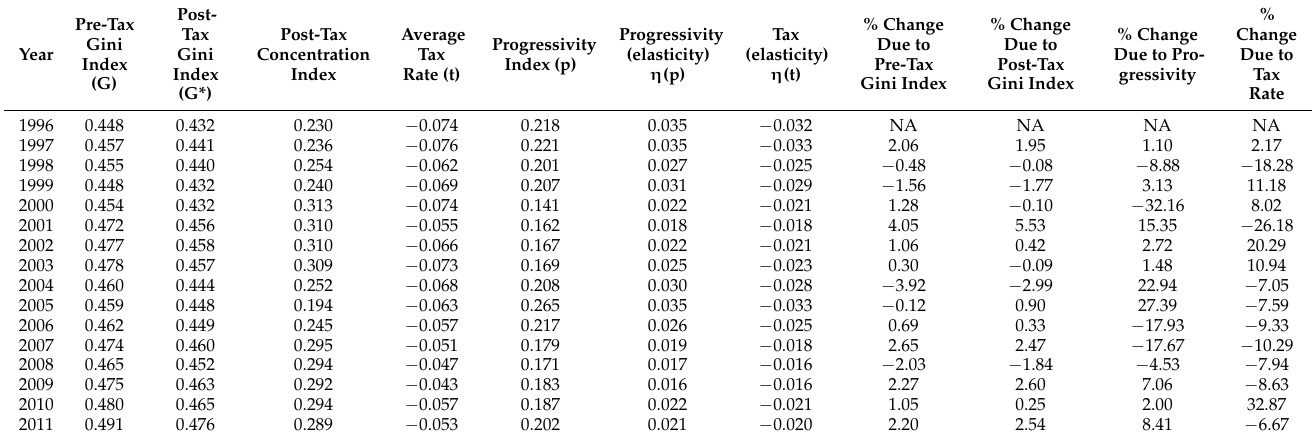
Table 2. Tax progressivity for male CPS respondents for years 1996 to